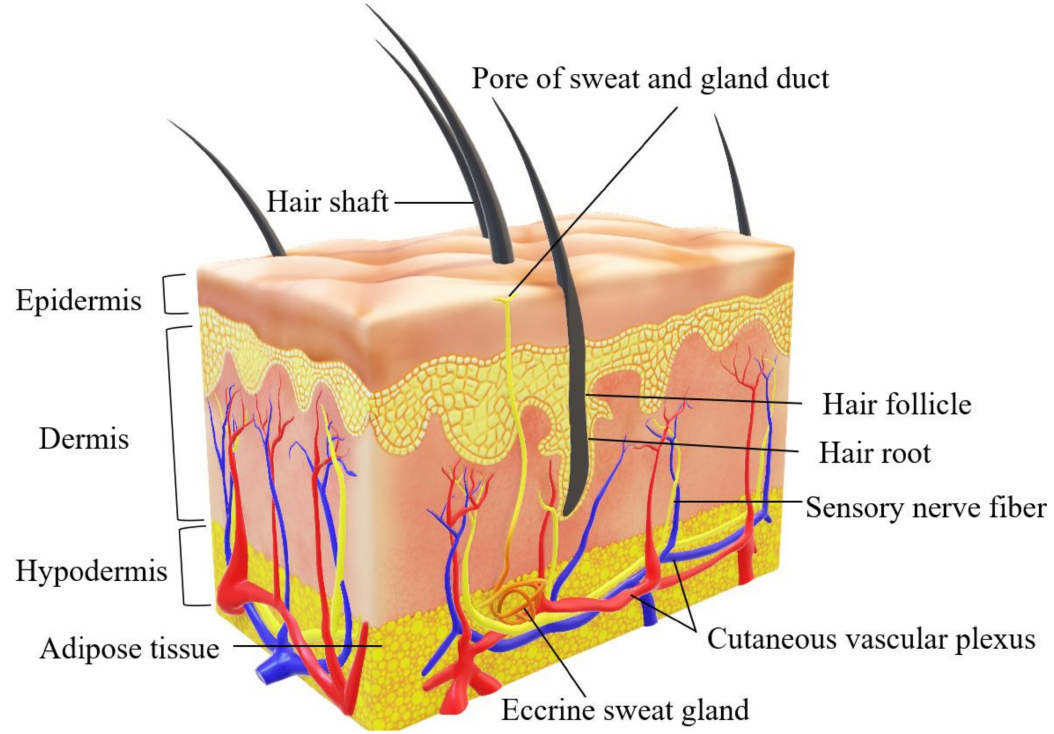
Figure 4. Complex human skin structure (epidermis, dermis, and